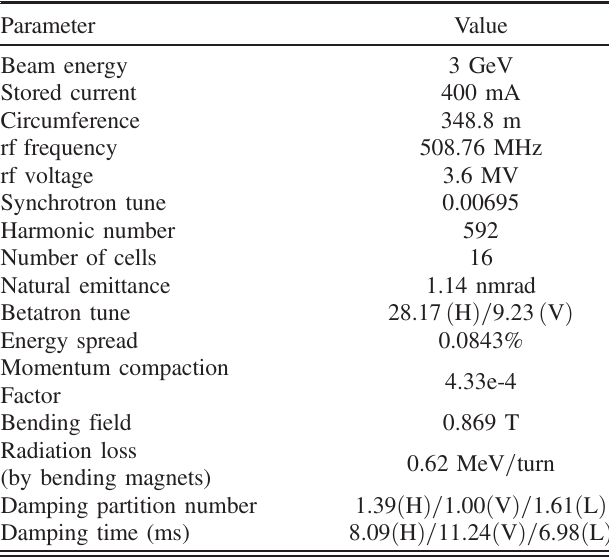
TABLE I. Machine parameters of the storage ring for the 3 GeV light source project [11]. The lattice is a four-bend achromat type. The capital letters H, V, and L in the table represent horizontal, vertical, and longitudinal,